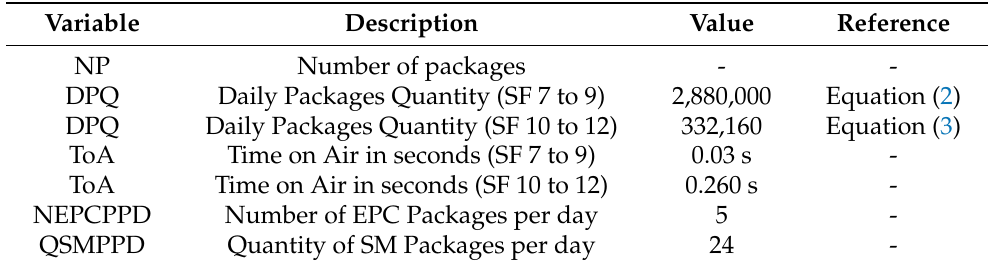
Table 6. Variable